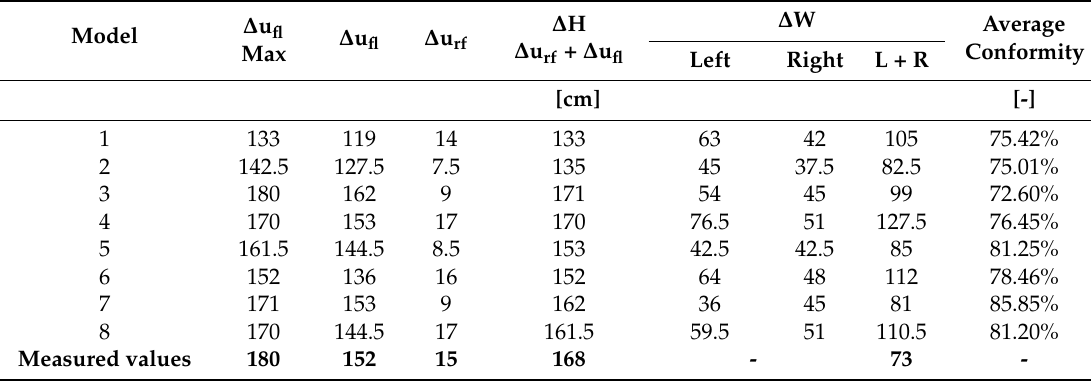
Bold—conformity up to 20% between the value from a model and the measurement. Charts of total displacements of the opening contour generated from model no. 3 and model no.